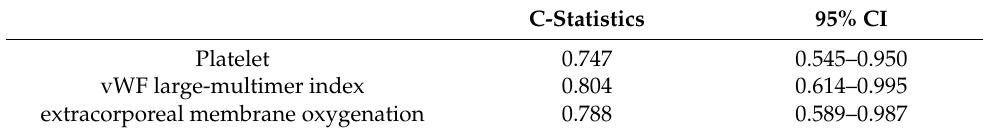
Table 3. C-statistics of variables that were enrolled in the multivariable